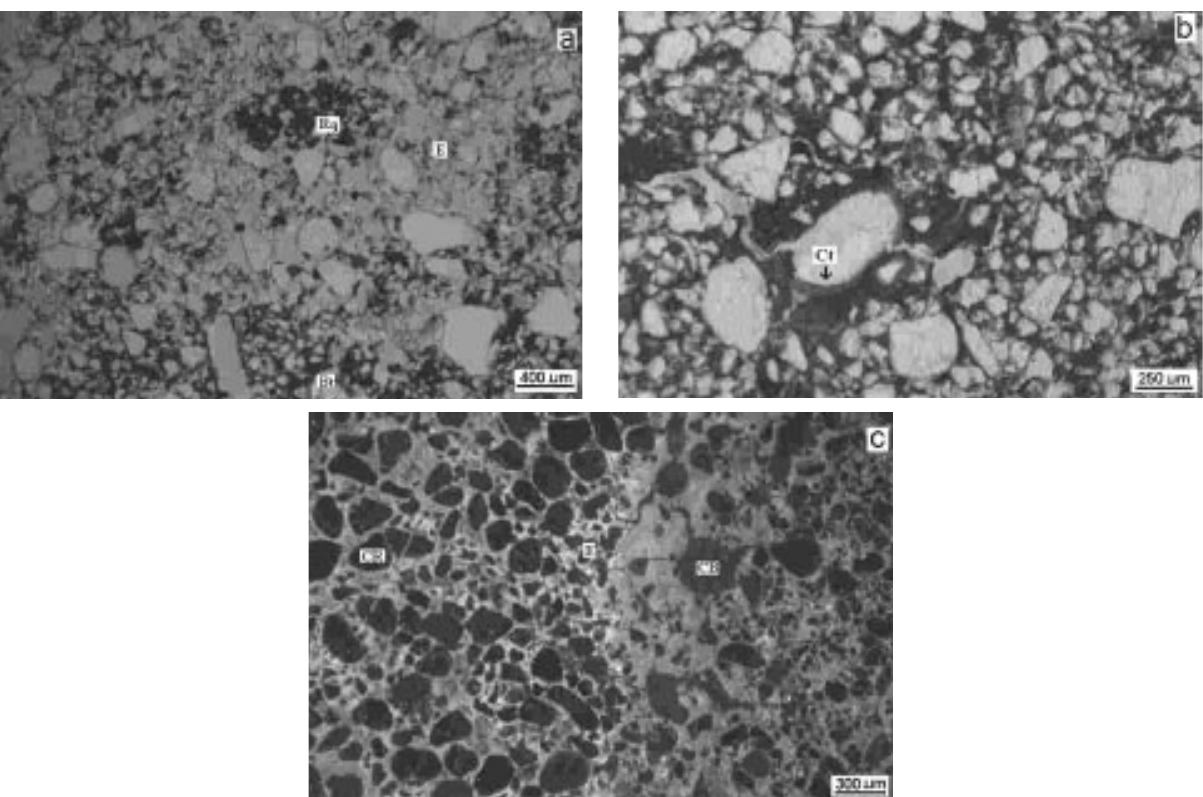
Figura 2. Micrografias de alguns materiais presentes nos solos estudados: (a) contato E/Bt1 (P1) evidenciando material argiloso formando uma relíquia (Rq) no centro da amostra, com aspecto semelhante ao horizonte Bt adjacente, circundando por material arenoso; (b) horizonte Bt1 (P1) evidenciando cutãs (Ct) em torno de uma cavidade; (c) horizonte CR (P3) evidenciando o aspecto mais ferruginizado da rocha (CR), com um material arenoso intermediário (E) e o material de alteração bruno-amarelado (CB) à